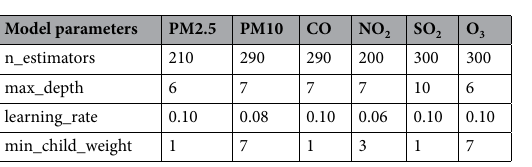
Figure 6. The flux diagram of the regression process, where NCP represents the concentration of pollutants measured at the national control point.